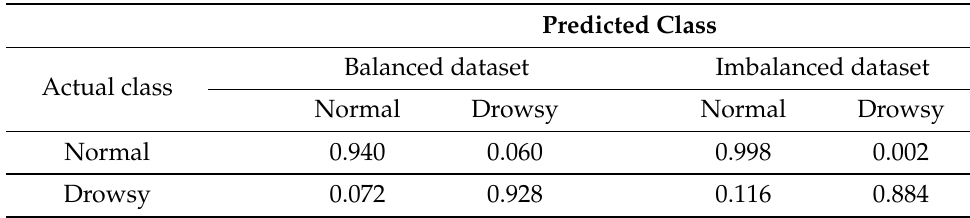
Table 5. Normalized confusion matrix of networks trained with the balanced dataset and the imbalanced dataset.